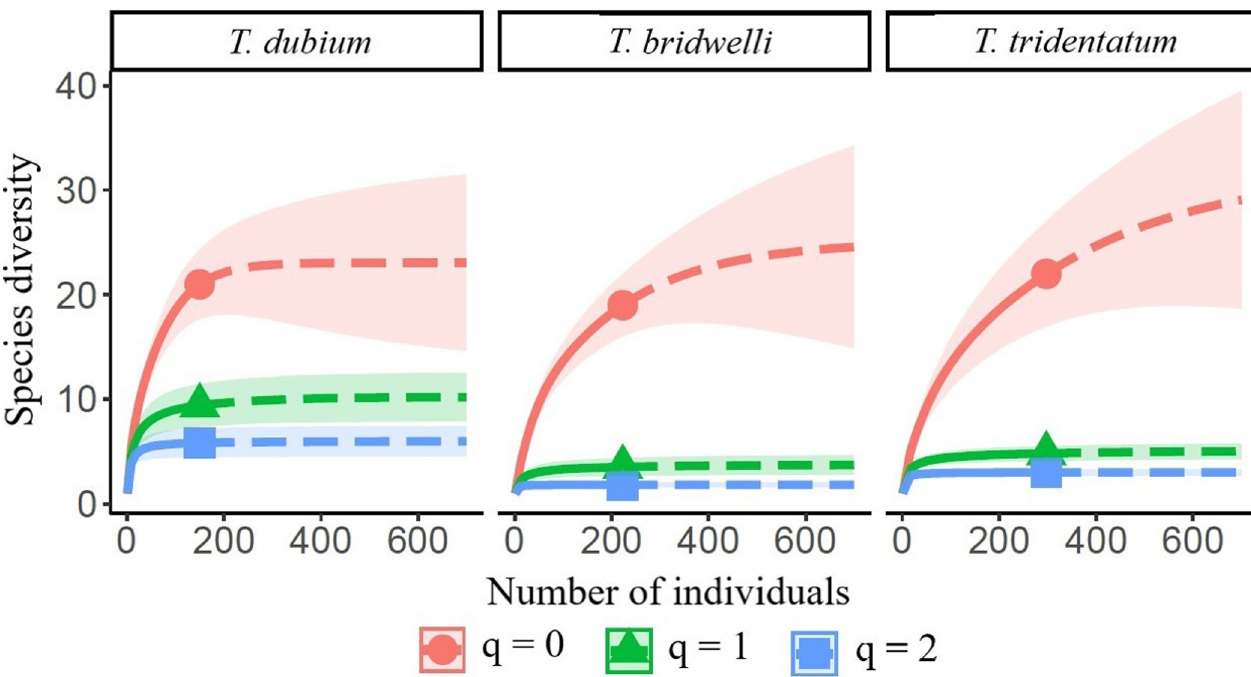
Fig 7. Species accumulation curve of captured spiders among the wasp species. The abscissa values represent the number of spiders that occurred within the wasps´ nests. The curves were extrapolated with 95% confidence intervals. Values of Hill numbers of order q = 0 (species richness), q = 1 (effective number of common species) and q = 2 (effective number of dominant species) are shown for each wasp species.